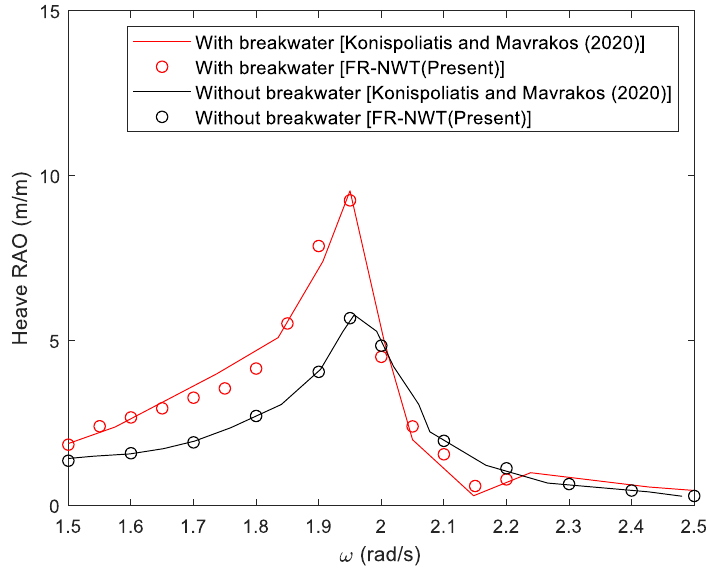
Figure 14. Overview of the computation domain with a WEC and breakwater (yellow: seawall-type breakwater, blue: ADZ).